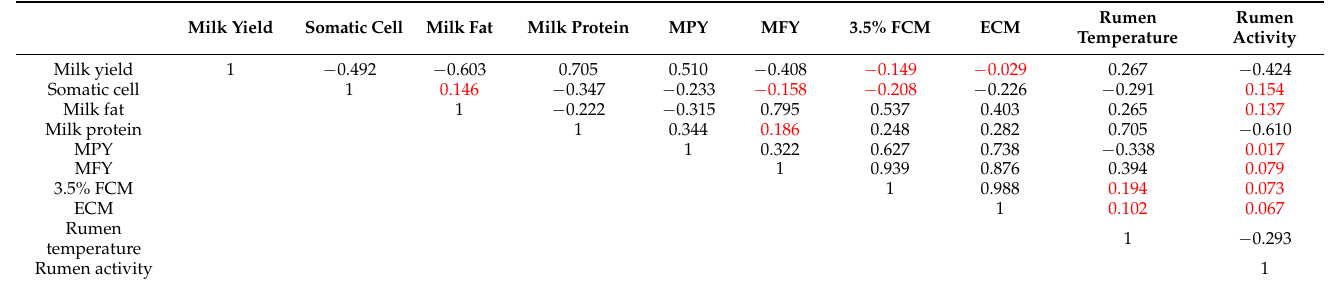
Table 8. Pearson’s correlation coefficients of considered traits for daily milking and rumen character- istics at Farm